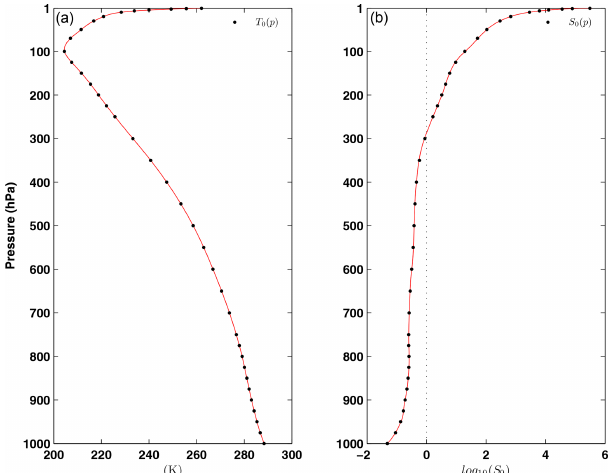
Figure 1. (a) Vertical profile of temperature at the ERA-Interim pressure levels (black dots) and interpolated to G L Gaussian levels (red line). (b) Stability parameter S 0 calculated from T 0 at original pressure levels (black dots) and from interpolated T 0 at Gaussian levels (red line). The stability parameter S 0 was made dimensionless by multiplying Eq. (6) by p 2 s /gH ∗ with H ∗ = 8km. The profiles were computed from the 3-D temperature field of the ERA-Interim reanalysis, covering the period from 1 January 1979 to 31 Decem- ber